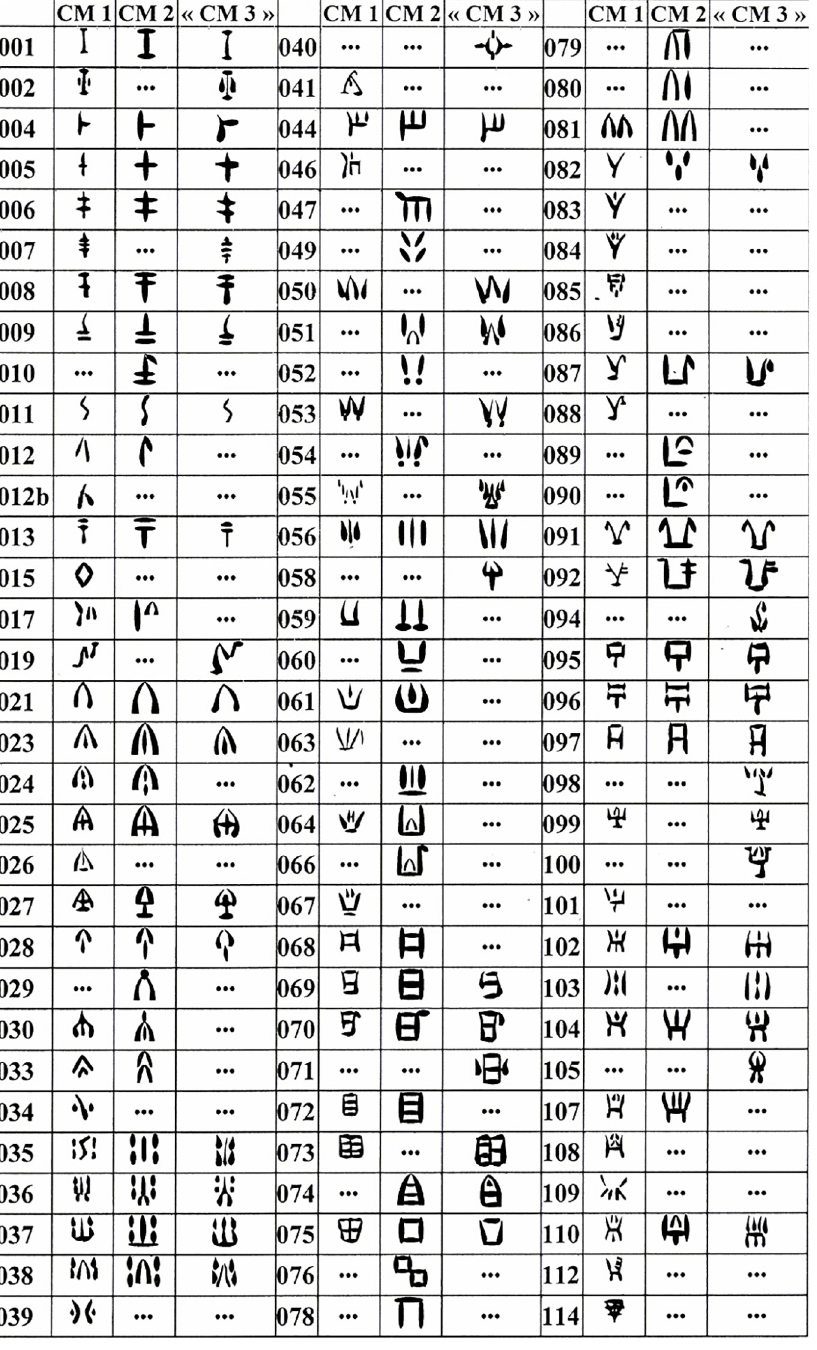
PLOS ONE | https://doi.org/10.1371/journal.pone.0269544 July 14, 2022 3 /